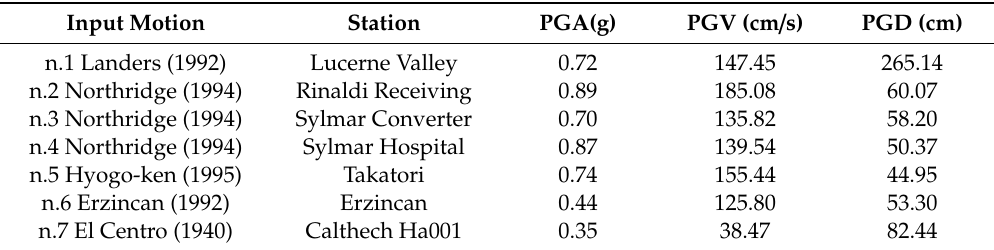
Table 1. Input motions characteristics: Peak Ground Acceleration (PGA), Peak Ground Velocity (PGV), Peak Ground Displacement (PGD).